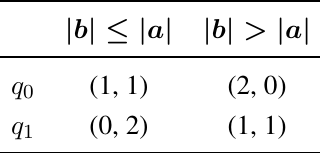
Table 2. The game’s payoff matrix. The state in the columns denote the automaton’s state after reading the final symbol when Player 2 stops the